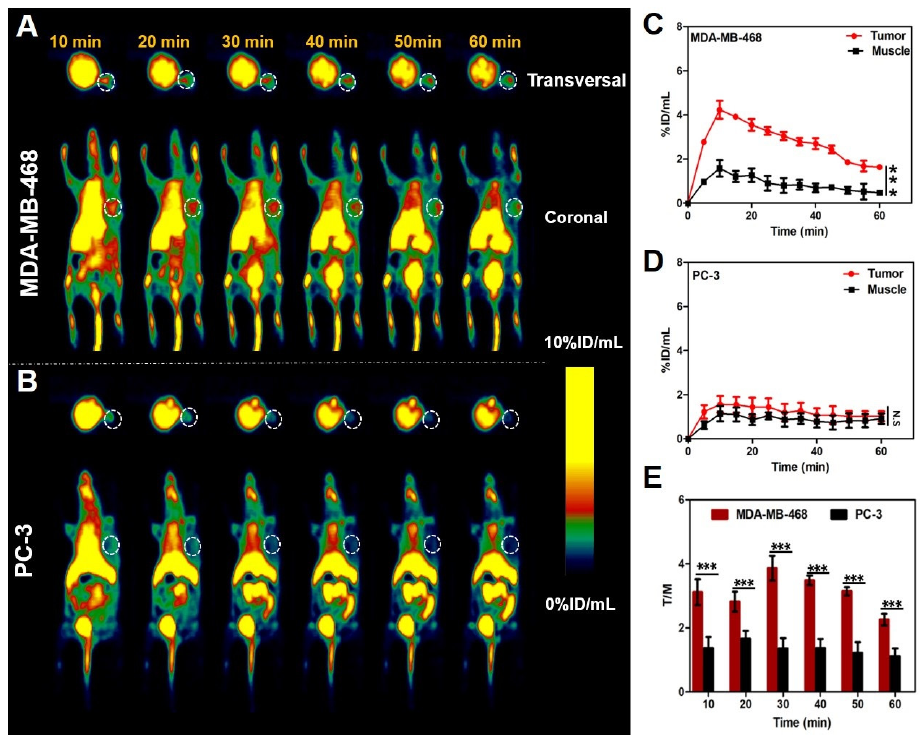
Figure 5. Micro-PET imaging studies of tracer [ 18 F] SF-AAN in MDA-MB-468 and PC-3 tumor-bearing mice. ( A , B ) Dynamic PET scanning of tumor-bearing mice within 1 h after injection of [ 18 F] SF-AAN (5.55 MBq). ( C , D ) Quantitative analysis of tracer uptake in tumor and muscle of MDA-MB-468 and PC-3 tumor-bearing mice, respectively. ( E ) Comparison of tumor-to-muscle uptake ratio between MDA-MB-468 and PC-3 tumor-bearing mice at different time post injection. N.S. denotes no significant difference; *** denotes p < 0.001.